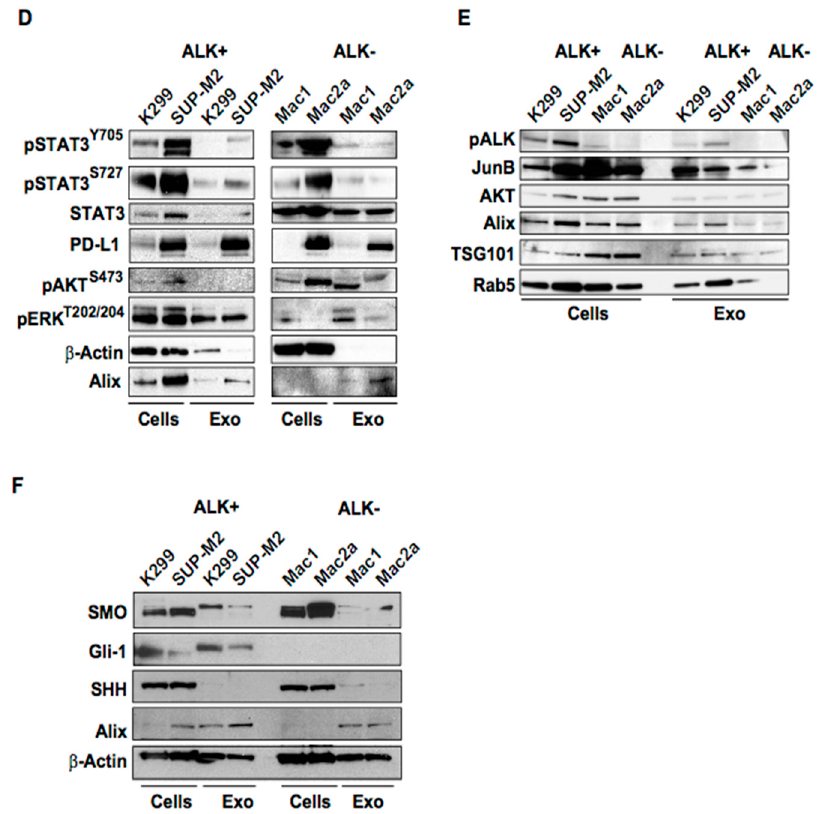
Figure 1. Molecular profiling of ALK+ and ALK- ALCL-derived exosomes: ( a ) Nanoparticle track- ing analysis (NTA) for the ALK+ (Karpas 299, Sup-M2) and ALK- (Mac1, Mac2A) ALCL exosomes. The mean size and particle concentration of the preparations are shown; ( b ) Immuno-electron mi- croscopy (iEM) staining with gold particles for CD30 on the ALCL-derived exosomes; ( c ) Western blot analysis of the ALK+ (upper panel) and ALK- (lower panel) ALCL whole cell and exosomal lysates shows the protein levels of Rab5 (exosomal marker), CD30, and AIF (quality control for the exosomal preparations); ( d ) Protein composition of the ALK+ and ALK- cell lines and exosomes. Alix is an exosomal marker; ( e ) Alongside the ALK+ ALCL cells and their respective exosomes are the NPM-ALK oncoprotein. The AP-1 transcription factor, known to be unregulated in ALK+ ALCL by NPM-ALK, is detected at a higher level in exosomes derived from ALK+ than ALK- ALCL cells. 11 Alix, Tsg101 and Rab5 are characteristic exosomal proteins; ( f ) Two crucial components of the sonic hedgehog pathway, SMO and Gli-1, which are known to be upregulated by NPM-ALK, are detected at a higher level in exosomes secreted by ALK+ than ALK- ALCL cell lines. Original images of western blot can be found at File S1 and donsitometry data for Western blots are shown in Figure S1.